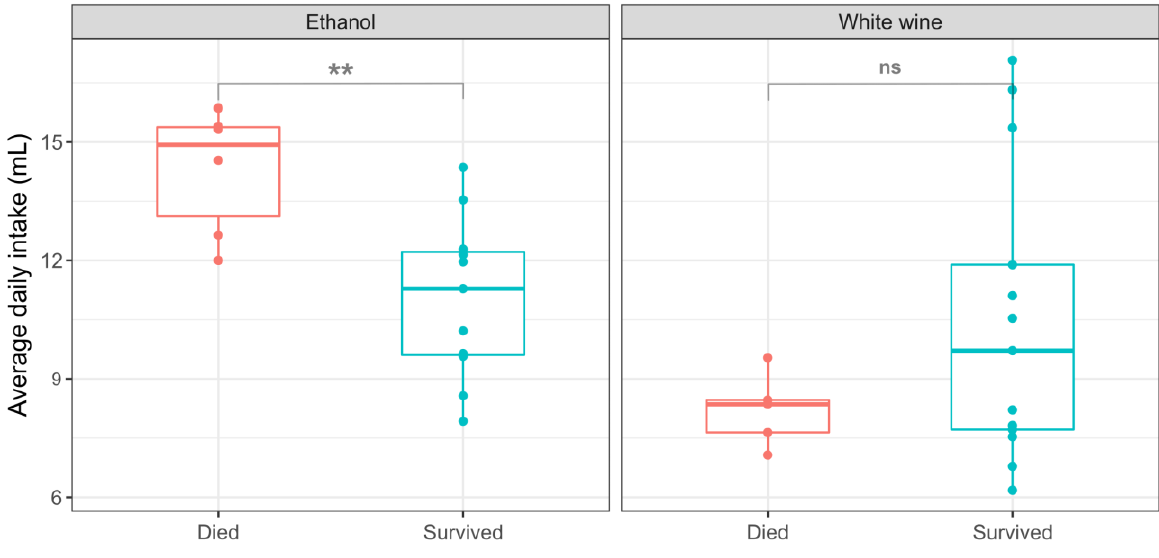
Figure 4. Comparison of daily intake of ethanol and white wine depending on the outcome (died or survived) four days after induction of MI. ns = not significant. ** denotes a p -value between 0.001 and 0.01.